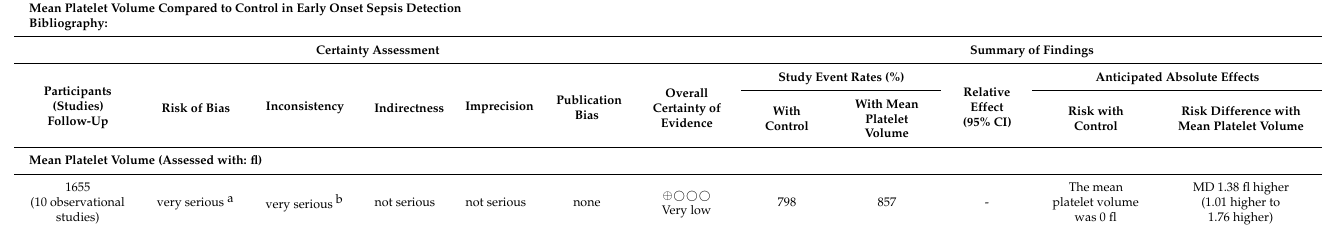
Table 3. GRADE summary of findings